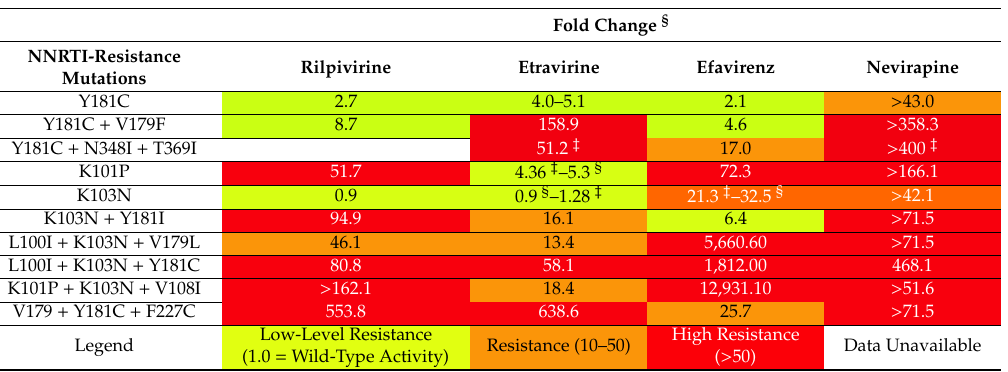
Table 2. NNRTI resistance from selected emergent HIV-1 RT